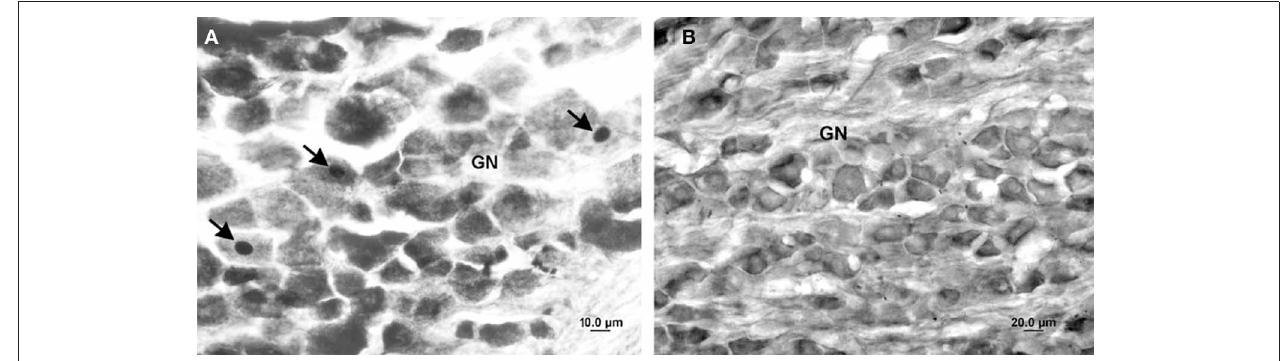
FIGURE 5 | Photomicrographs of the nodose ganglion in the iSLN-stimulated (A) and LPS-treated (B) animals. The arrows mark Fos-positive neurons in the iSLN-stimulated animal. No FLI increase was observed in any LPS- or vehicle-treated animal. GN, ganglion nodosum.